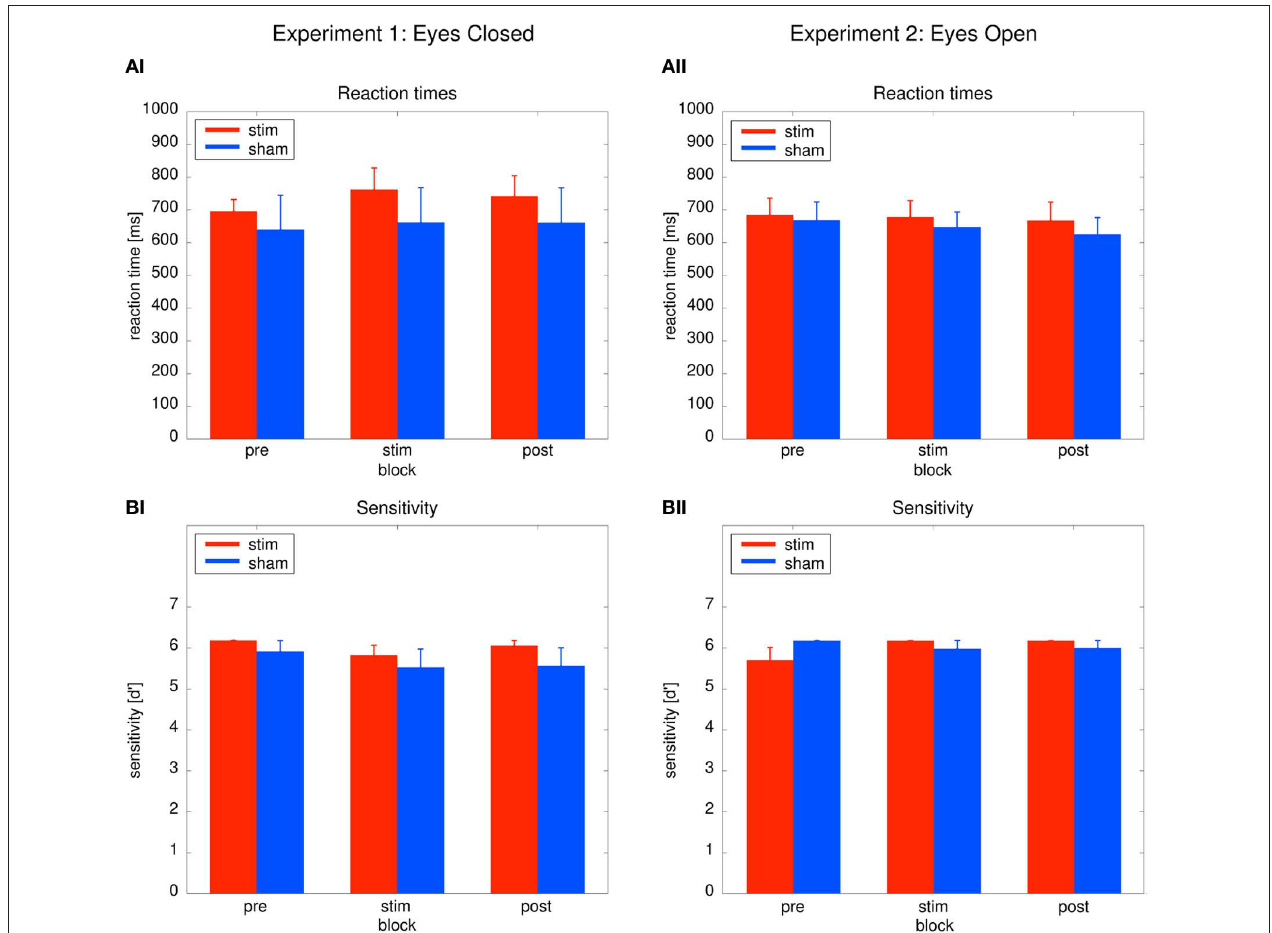
FIGURE 3 | Behavioral results. Left: Experiment 1, right: Experiment 2; red: tACS stimulation group, blue: sham stimulation group. (AI,AII) Reaction times: average reaction times for the stim and the sham group for the three